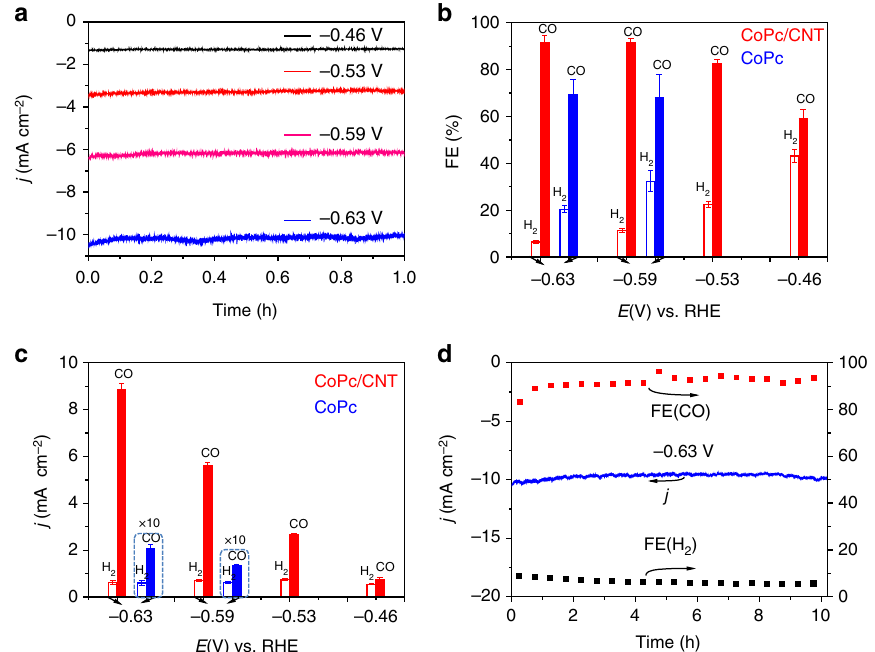
Figure 2 | CO 2 electroreduction catalysed by the CoPc/CNT hybrid. ( a ) Representative chronoamperograms of CO 2 electroreduction catalysed by the CoPc/CNT(2.5%) hybrid for 1h at various potentials in 0.1M KHCO 3 aqueous solution. ( b ) Faradaic efficiencies of CO 2 reduction products in the gas phase for CoPc/CNT(2.5%) (red) and CoPc (blue) at various potentials. ( c ) Partial current densities of CO 2 reduction products in the gas phase for CoPc/ CNT(2.5%) (red) and CoPc (blue) at different potentials. The average values and error bars in ( b , c ) are based on six measurements during three reaction runs (two product analysis measurements were performed in each run). The error bars represent s.d. of six measurements. ( d ) Long-term stability of the CoPc/CNT(2.5%) hybrid catalyst for CO 2 reduction operated at (cid:2) 0.63V versus RHE for 10h. The data are all iR